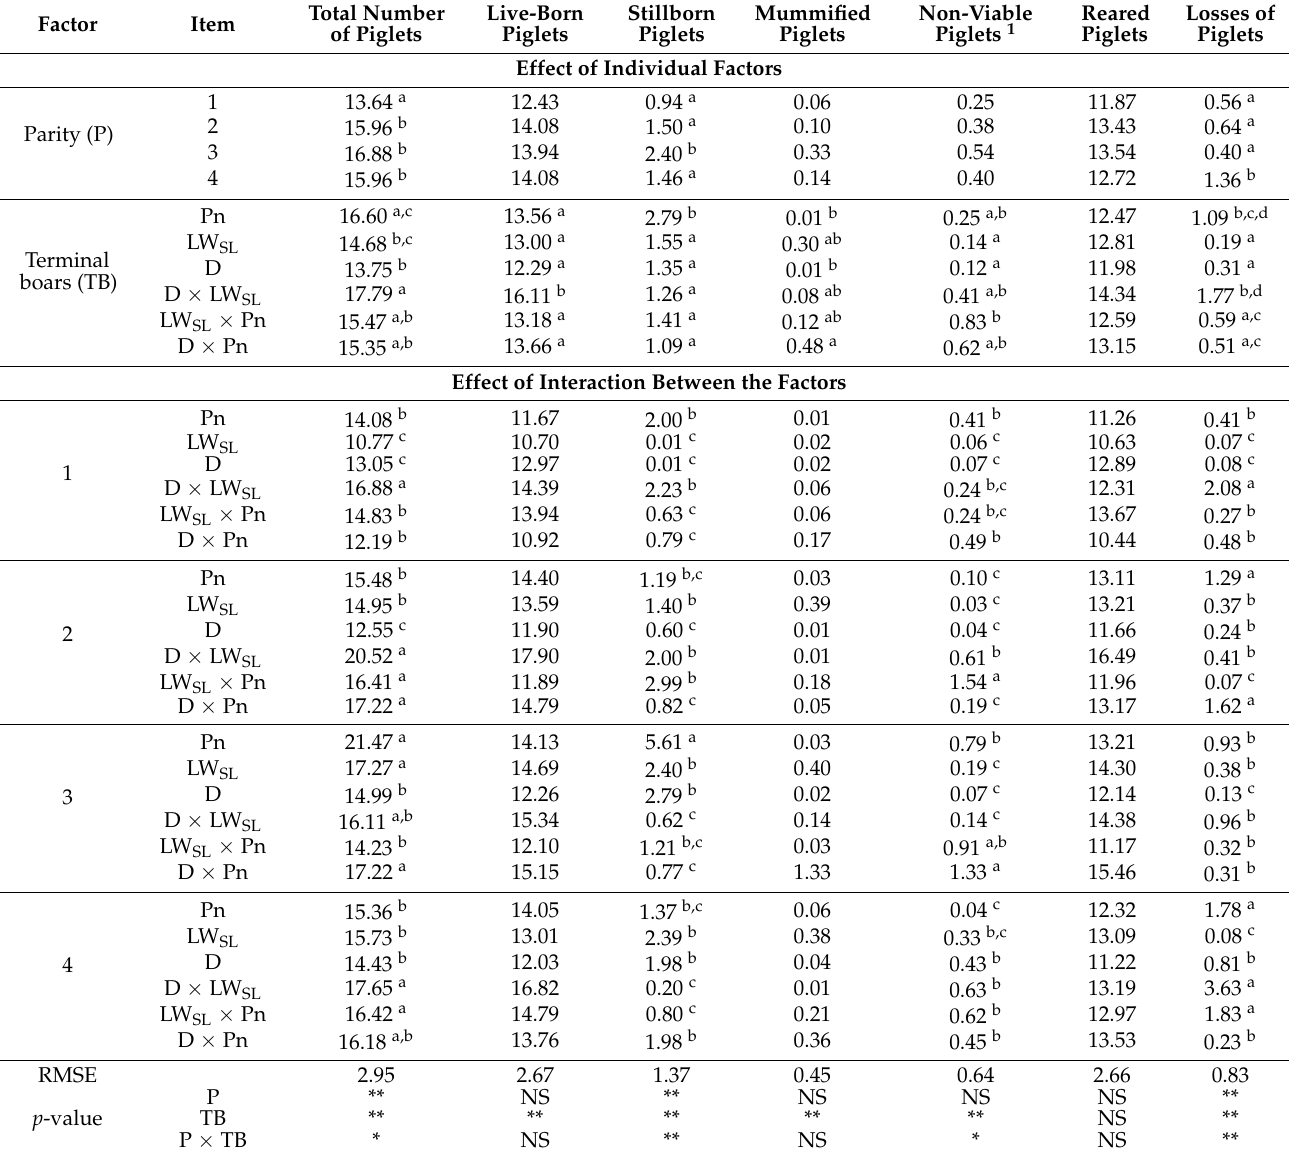
Table 4. The effect of parity and terminal boar on selected reproductive parameters of sows and losses of piglets (pcs/litter).